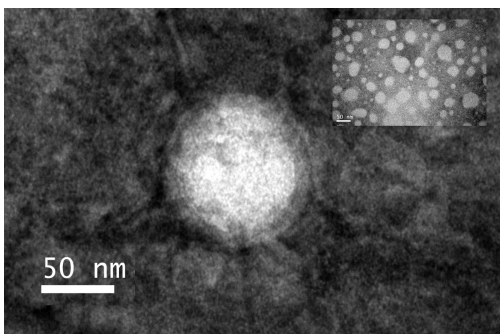
Figure 4. The distribution and the core–membrane structure image of RBGPs observed by TEM.